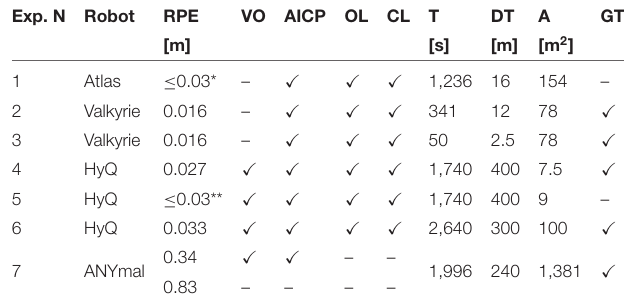
TABLE 2 | Summary of the